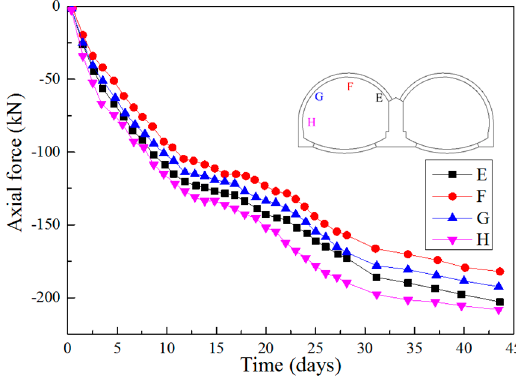
Figure 23. Time history plots of the axial forces in secondary linings in the K89+729 section.